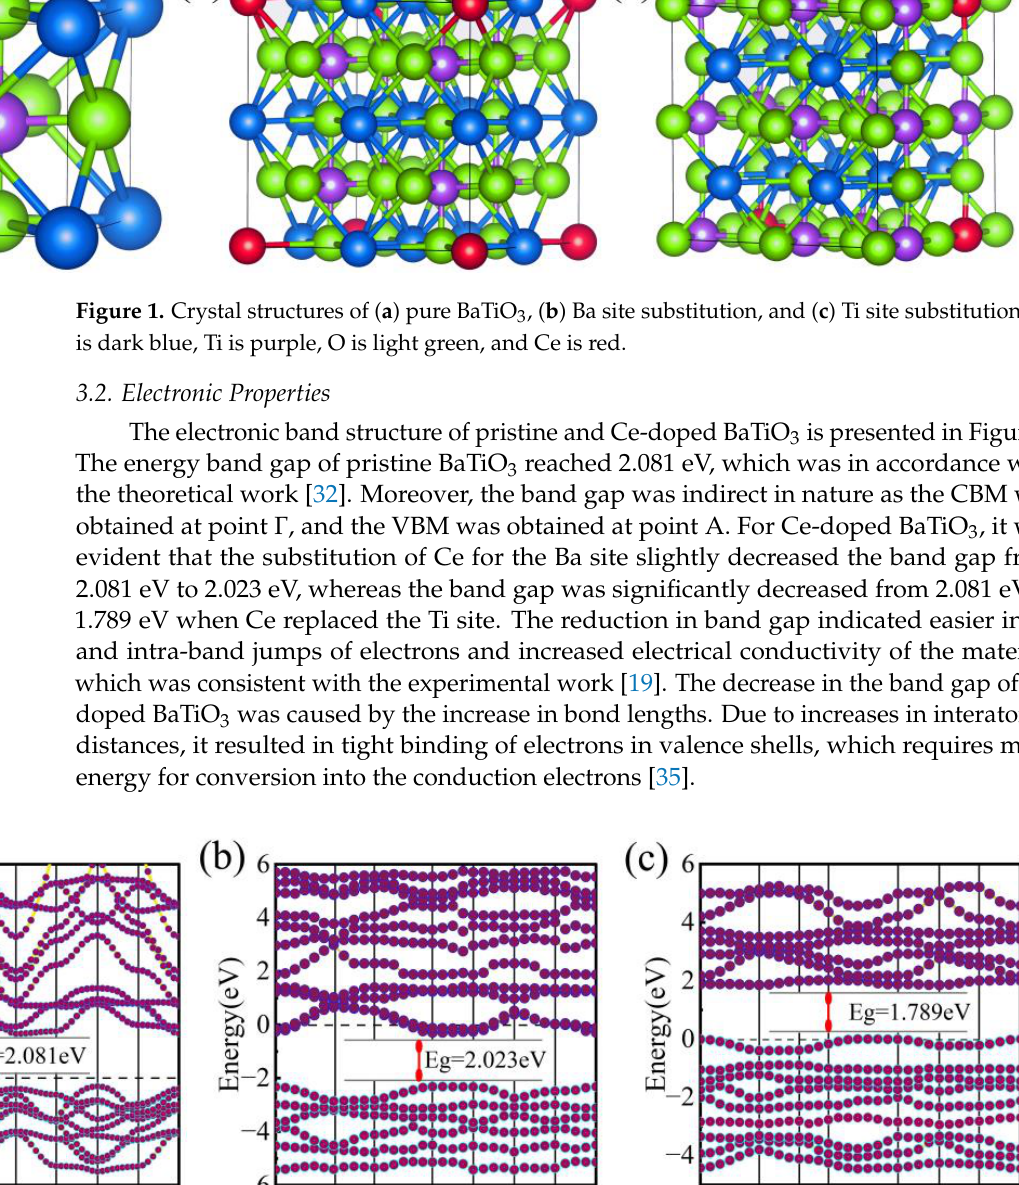
Figure 1. Crystal structures of ( a ) pure BaTiO 3 , ( b ) Ba site substitution, and ( c ) Ti site substitution. Ba is dark blue, Ti is purple, O is light green, and Ce is red.